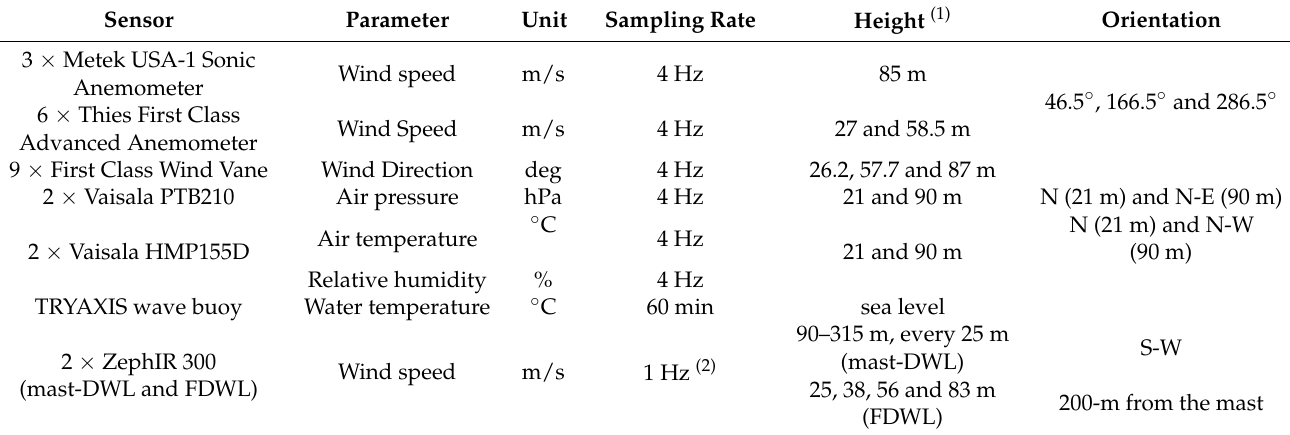
Table 1. Main specifications of the instruments from the IJmuiden test site. Detailed information about the sensors arrangement and specification can be found in